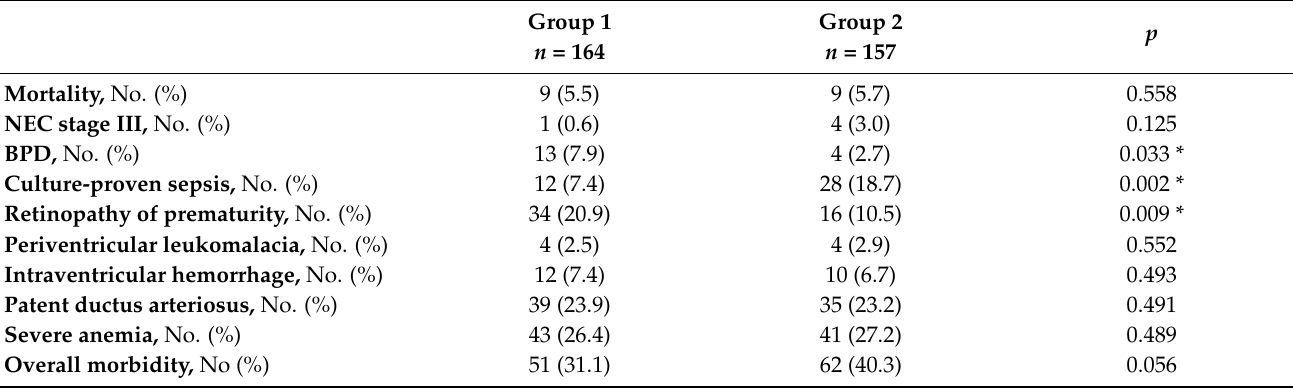
Figure 3. Rate of occurrence of hyperglycemia in the two study groups during the first week of life. The rate of hypoglycemia within 0–7 DoL was similar between the two groups (12.4 vs. 12; p = 0.524). The rate of increase of the separate macronutrients (dextrose, amino acids and lipids) are reported in Supplementary Materials (Figure S1–S3). Data analyzed also per protocol showed similar results on the primary outcome. De- spite the overall morbidity not being different among groups, we observed that the rate of BPD and ROP were significantly higher in Group 1 than Group 2 (Table 3). Whereas the rate of culture-proven sepsis was significantly lower in Group 1 compared to Group 2 (Table 3). Table 3. Morbidities of newborns included in the study.